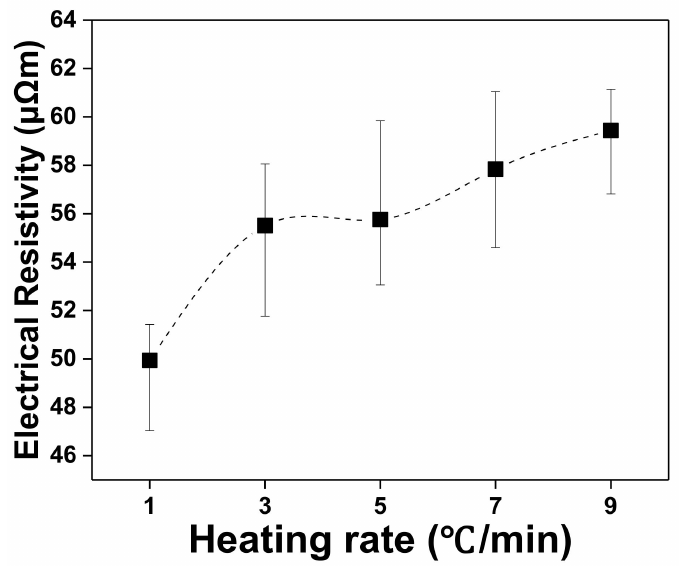
Figure 6. Electrical resistivity of graphite blocks as a function of heating